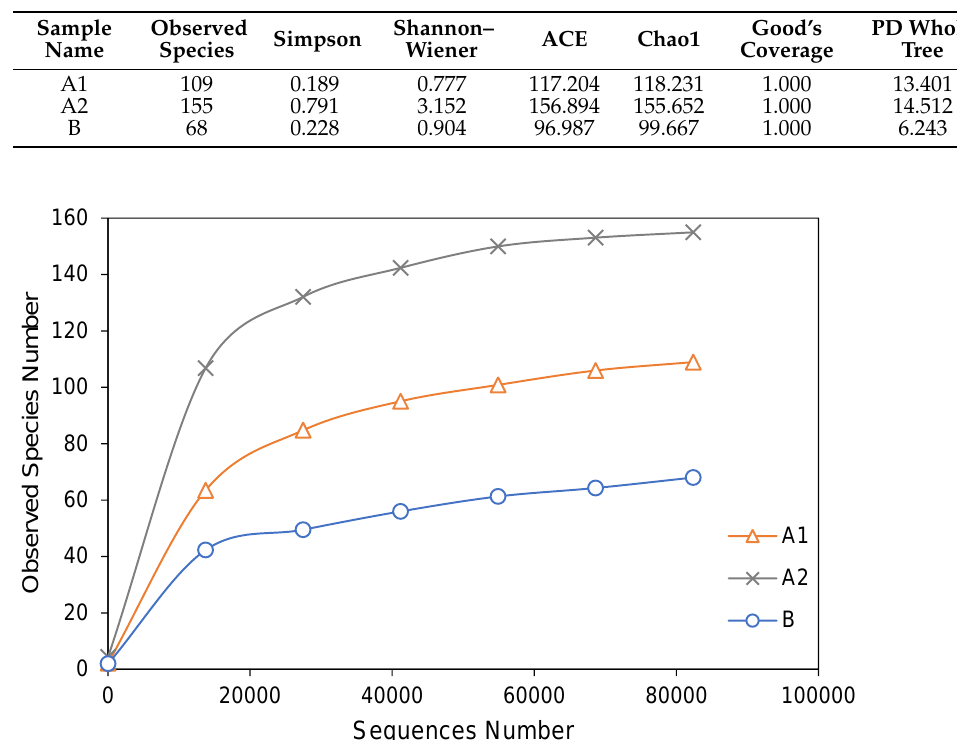
Figure 2. Rarefaction curves of the three extremely halophilic microbial samples displaying the observed species number compared to the observed OTUs at a certain depth of sequencing. Table 1. Alpha diversity indices.